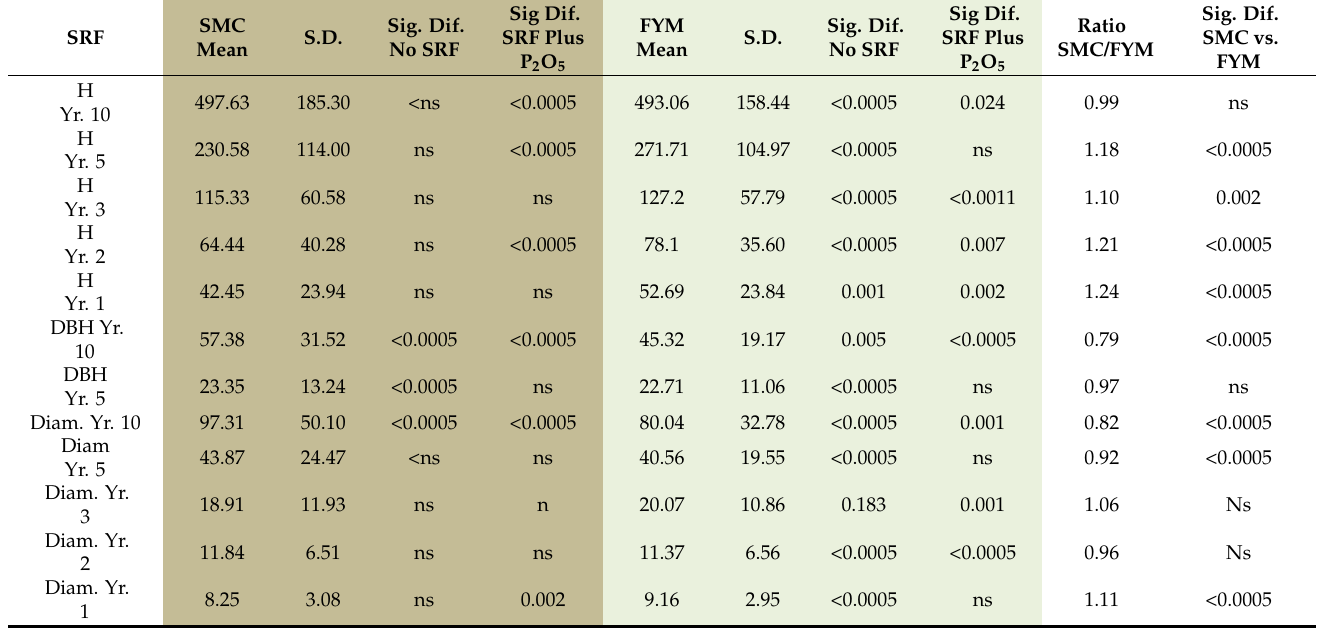
Table 8. Comparison of SMC- and FYM-planted trees given additional SRF (Nb: height (H): cm; DBH: mm, Diam: (diameter above root collar): mm, ns: differences not significant).